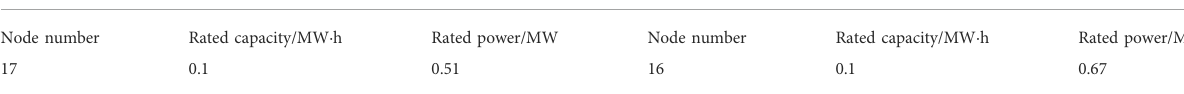
TABLE 3 BESSs optimal con fi guration scheme. BESS No.1 BESS No.2